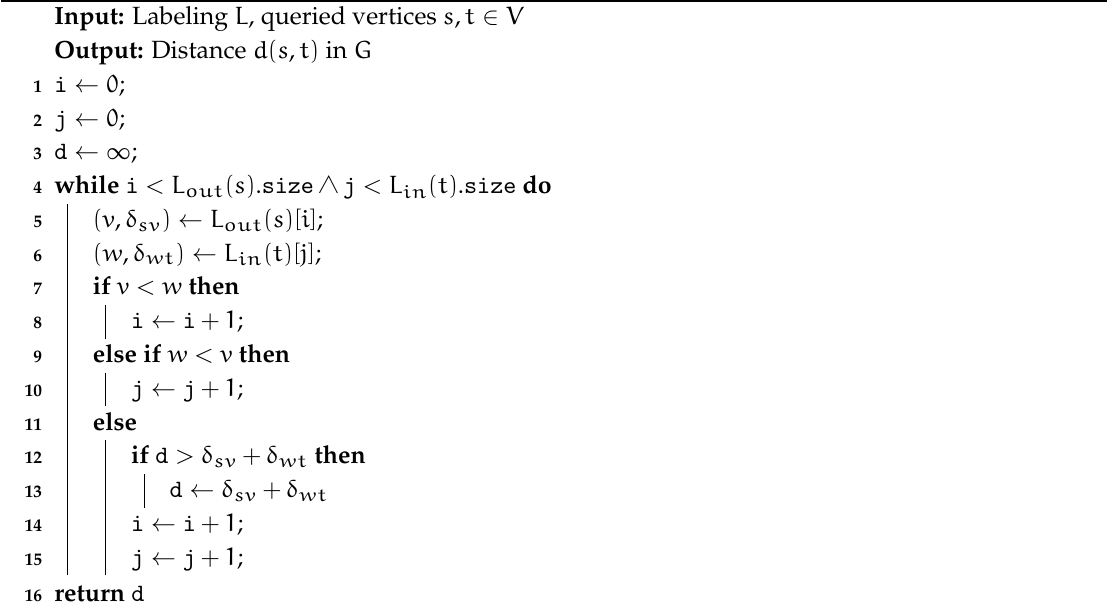
Algorithm 1: Query algorithm for minimal well-ordered labelings